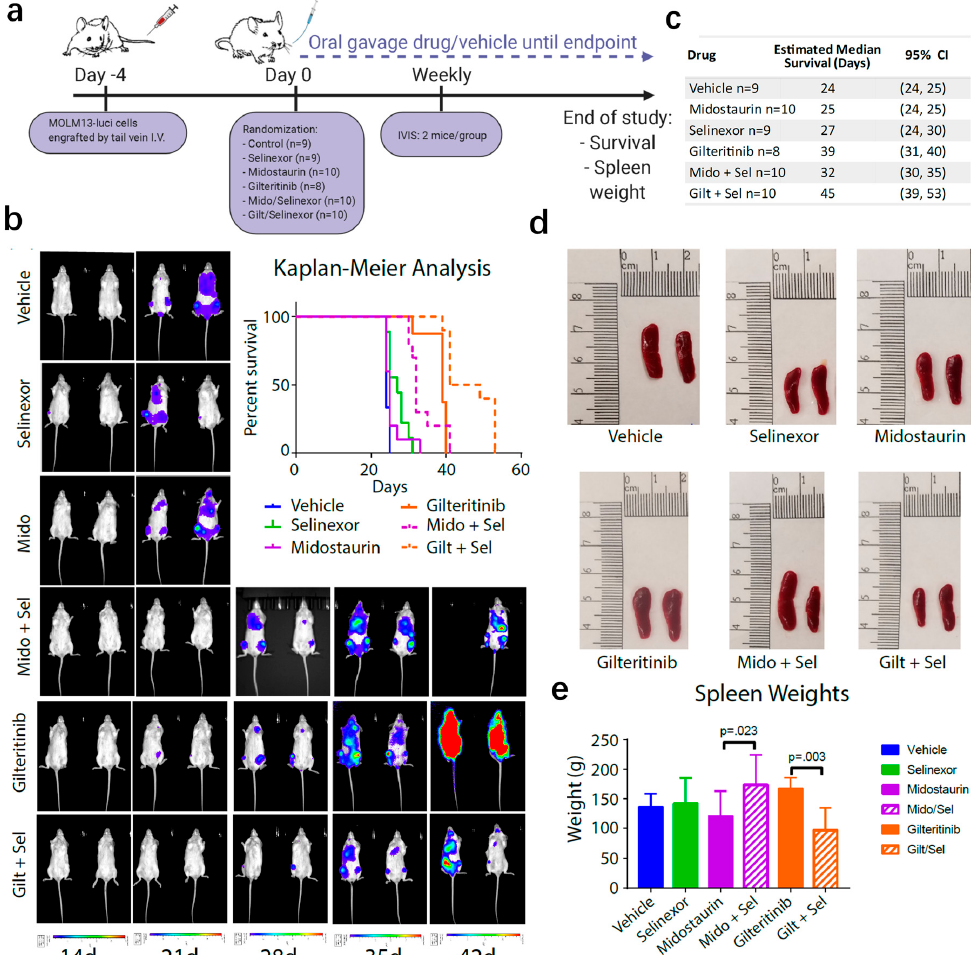
Figure 4. In vivo pharmacologic validation of XPO1 as a cotarget with FLT3. ( a ) Design of murine experiment where NSG mice were engrafted with MOLM-13 cells expressing luciferase and treated with vehicle, 50 mg/kg midostaurin daily, 30 mg/kg gilteritinib daily, 15 mg/kg selinexor twice weekly, or combinations of midostaurin or gilteritinib plus selinexor. ( b ) IVIS imaging of two mice per group and Kaplan-Meier analysis of survival of the entire cohort. ( c ) Estimated mean survival for each group with the 95% confidence interval (CI). ( d ) Representative images of spleens from each group ex vivo. ( e ) Differences in spleen weights between groups were estimated using analysis of variance (ANOVA) methods. p -values were adjusted for multiple comparisons within each drug combination using Holm’s procedure.